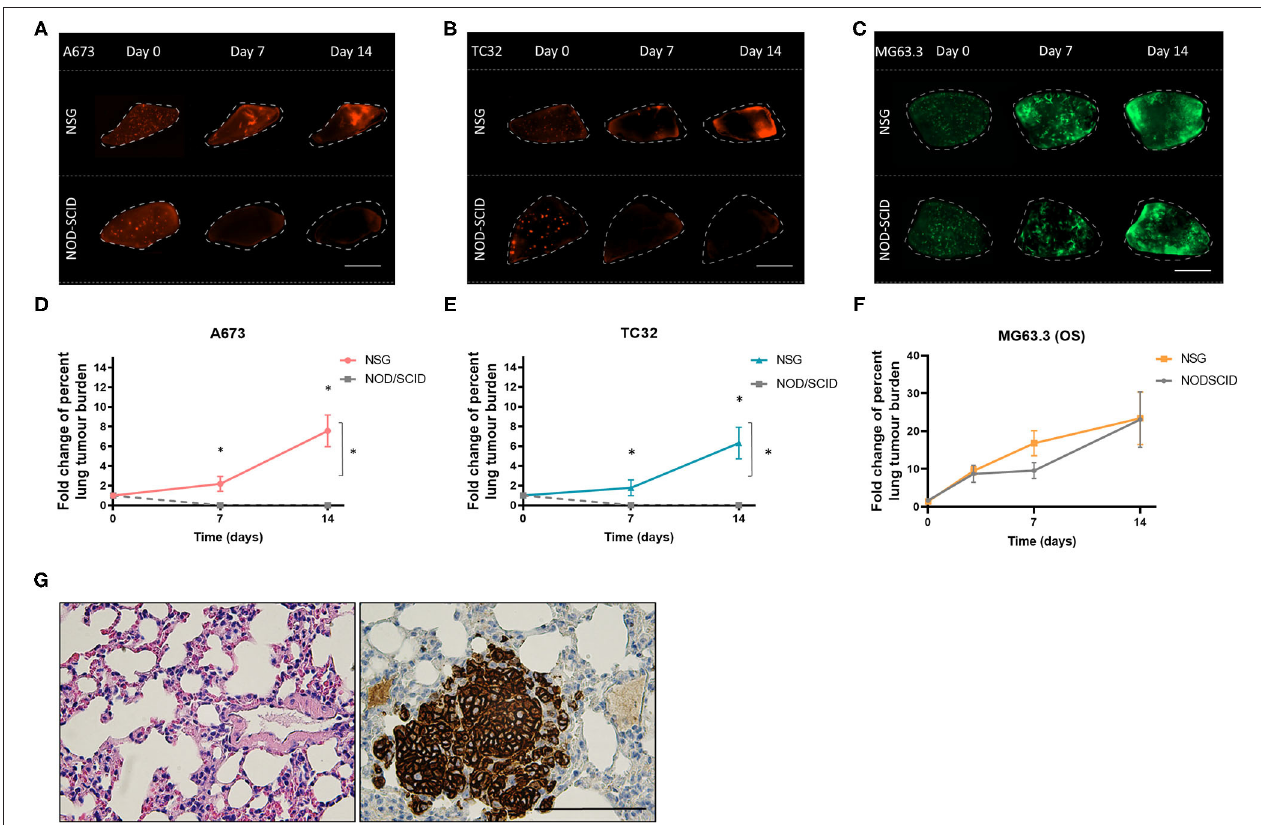
FIGURE 2 | Ex vivo growth of EwS cells is maintained in NSG mice. Fluorescence images for A673 (A) TC32 (B) and MG63.3 (C) tdTomato + EwS cells at day 0, 7, and 14 post-injection. Scale bars = 1mm. Fold change in the percent metastatic tumor burden of A673 (D) , TC32 (E) , and (F) MG63.3 cells. Three animals were included per group ( n = 3) and a minimum of 10 lung tissue sections were analyzed per animal. Results are shown as mean ± SD. Statistical assessment of differences was determined using two-way ANOVA tests with a Tukey’s post-hoc test (* p < 0.01). (G) CD99 immunoreactive TC32 EwS cells in NSG mouse lung slices at 5 weeks after renal subcapsular implantation of EwS cells. Three animals were included per group ( n = 3) and a minimum of 10 lung tissue sections were analyzed per animal. Scale bars = 100 µ